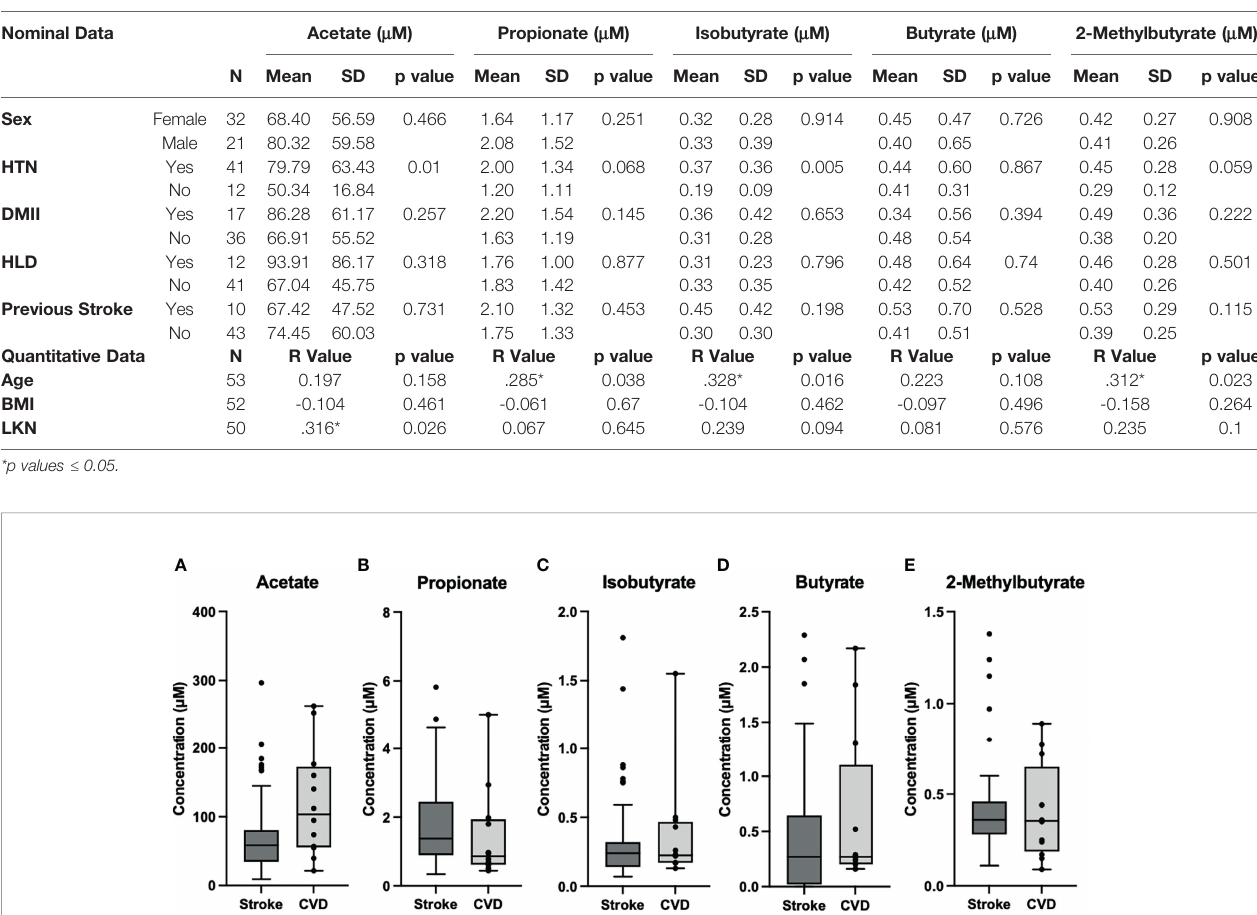
SCFAs. Three systemic proteins (Apolipoprotein M (APOM), C- X-C motif chemokine ligand (CXCL)10, and IL-2 and six intracranial proteins (Colony stimulating factor-1 (CSF-1), CXCL10, IL-12B, IL-6, TNF- a , and VCAM1 ( Figure 4 ) were correlated with Propionate, Isobutyrate, Butyrate, and 2- Methylbutyrate. Systemic CXCL9 and Cluster of Differentiation 8A (CD8A), as well as intracranial IL-17A, were correlated with Acetate, Isobutyrate, Butyrate, and 2-Methylbutyrate. Systemic VCAM1 and IL-17A correlated with Acetate, Propionate (p=0.053*), Isobutyrate, and 2-Methylbutyrate. Of these proteins, the only one that was signi fi cant by multi-linear regression with SCFAs was systemic IL-2 (R 2 = 0.261), which interestingly had Acetate (p=0.009) and Isobutyrate (p<0.001) as predictors of IL-2 levels. STRING Networks were created separately using all systemic proteins with >3 SCFA correlations and all intracranial proteins with >3 SCFA correlations ( Figure 4 ) and the associated biological processes were reported ( Table 4 ).